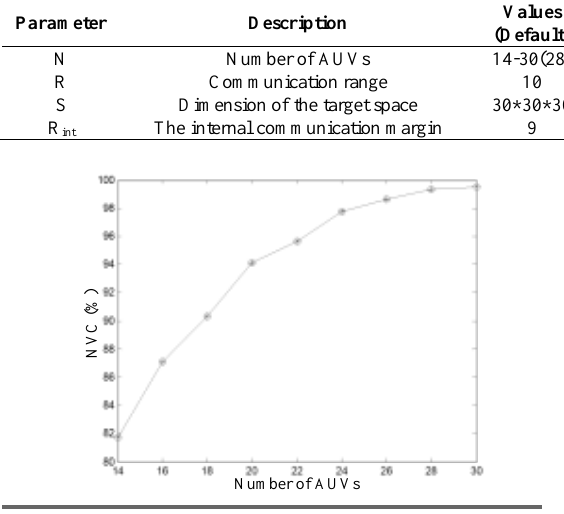
Figure 5. NVC versus number of AUVs.